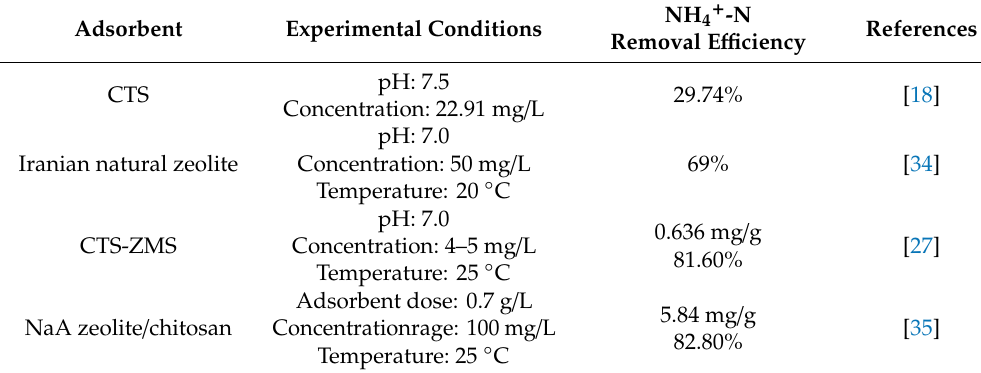
Table 2. A comparative evaluation of adsorption capacity of other experimental conditions of di ff erent adsorbents for NH 4 + -N